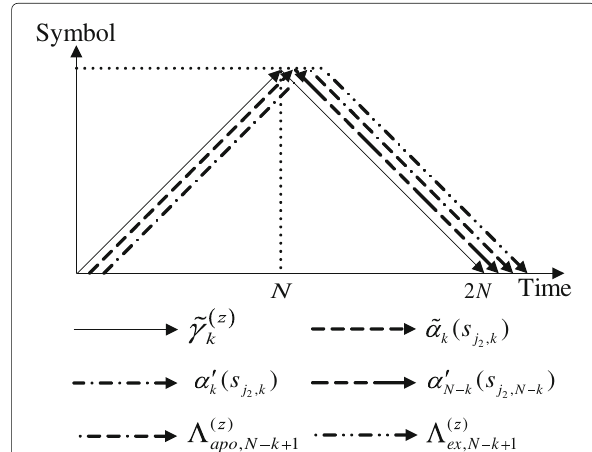
Fig. 3 Timing chart of the proposed decoding